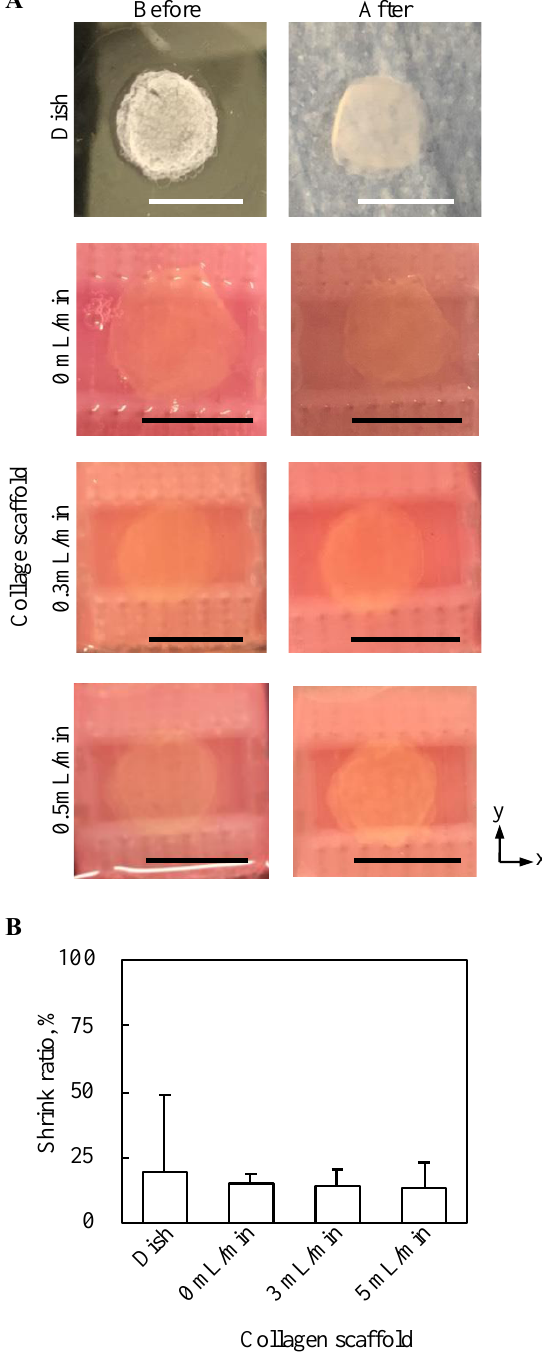
Figure 7. Evaluation of the morphology from the top view of tissue cultured using each method. The macro top-view images of the tissues ( A ). The shrink ratios of tissues are shown ( n = 3~7, mean ± SD) ( B ).